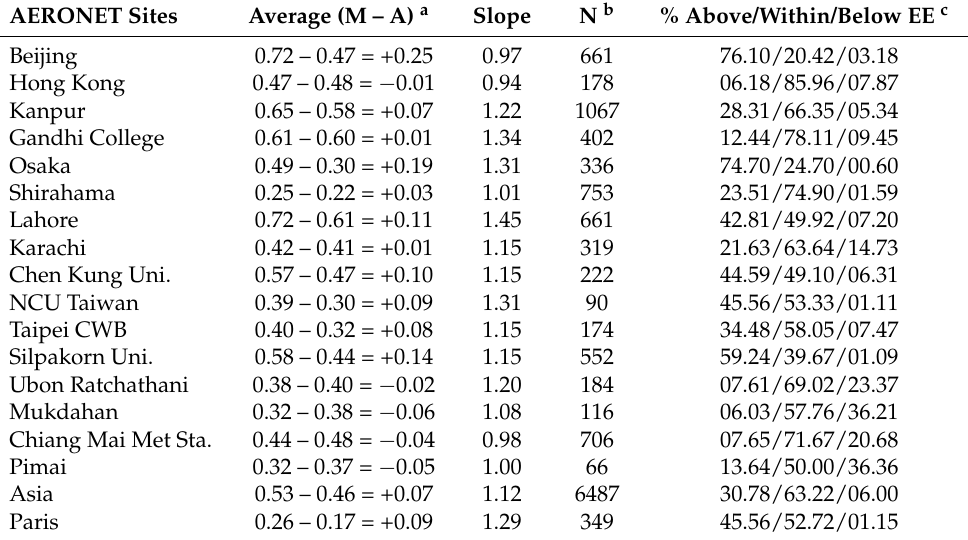
Table 3. Statistical summary for validation of MYD04_10K AOD observations over